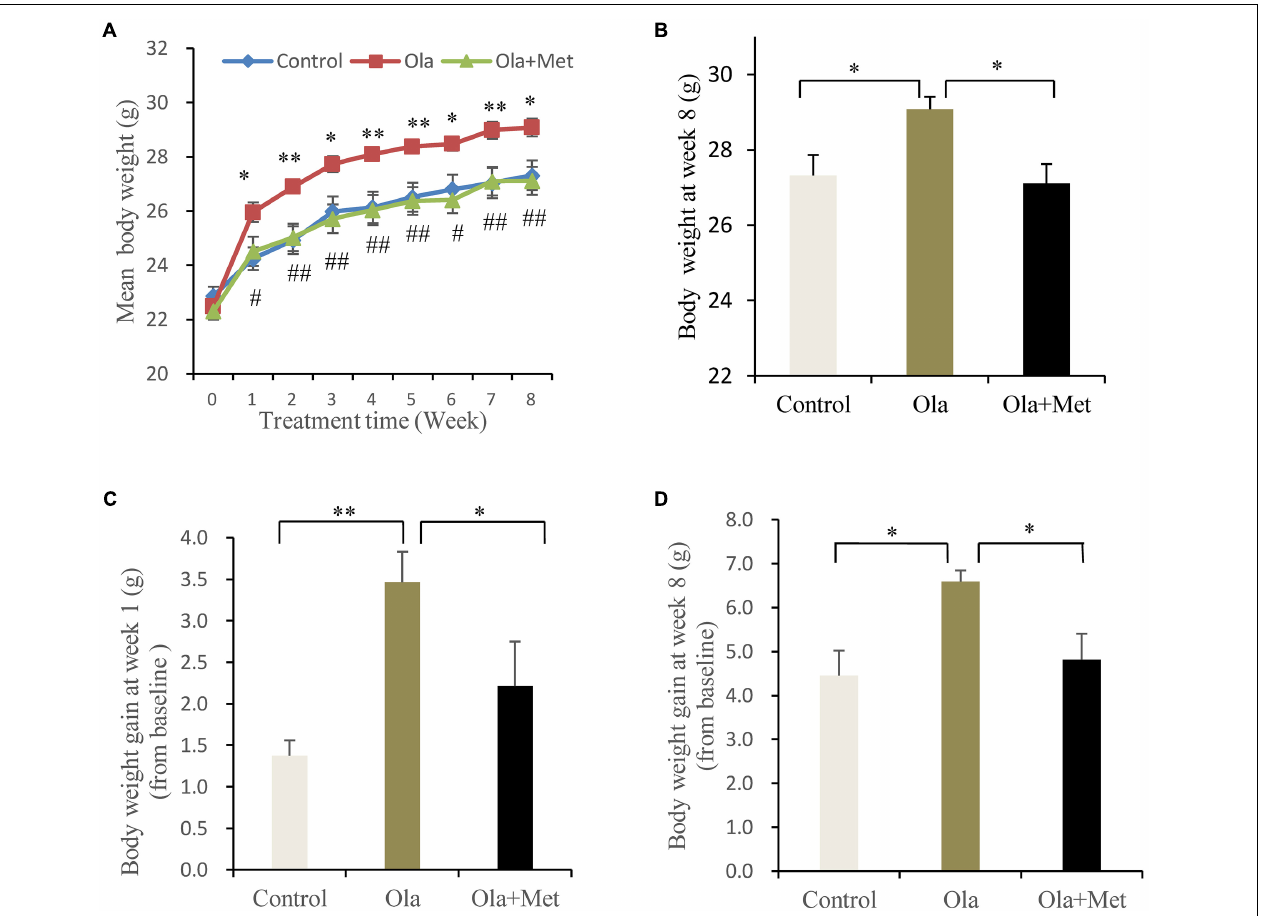
FIGURE 1 | Comparison of the body weight between different treatment groups in C57BL/6 mice. C57BL/6 mice were treated with olanzapine (4 mg/kg/day, Ola), olanzapine (4 mg/kg/day, Ola) + metformin (150 mg/kg/day, Met), or saline for 8 weeks. (A) Body weight of mice from olanzapine group (Ola), olanzapine + metformin group (Ola +Met), and control group (Control) during 8-week of treatment. ∗ p < 0.05, ∗∗ p < 0.01, Ola vs. Control group; # p < 0.05, ## p < 0.01, Ola +Met vs. Ola group. (B) Body weight measured at the end of 8-week treatment. (C) Body weight gain after the first week of treatment. (D) Body weight gain after 8 weeks treatment. All the results ( n = 10 for each group) were expressed as mean ± SEM. ∗ p < 0.05, ∗∗ p < 0.01.